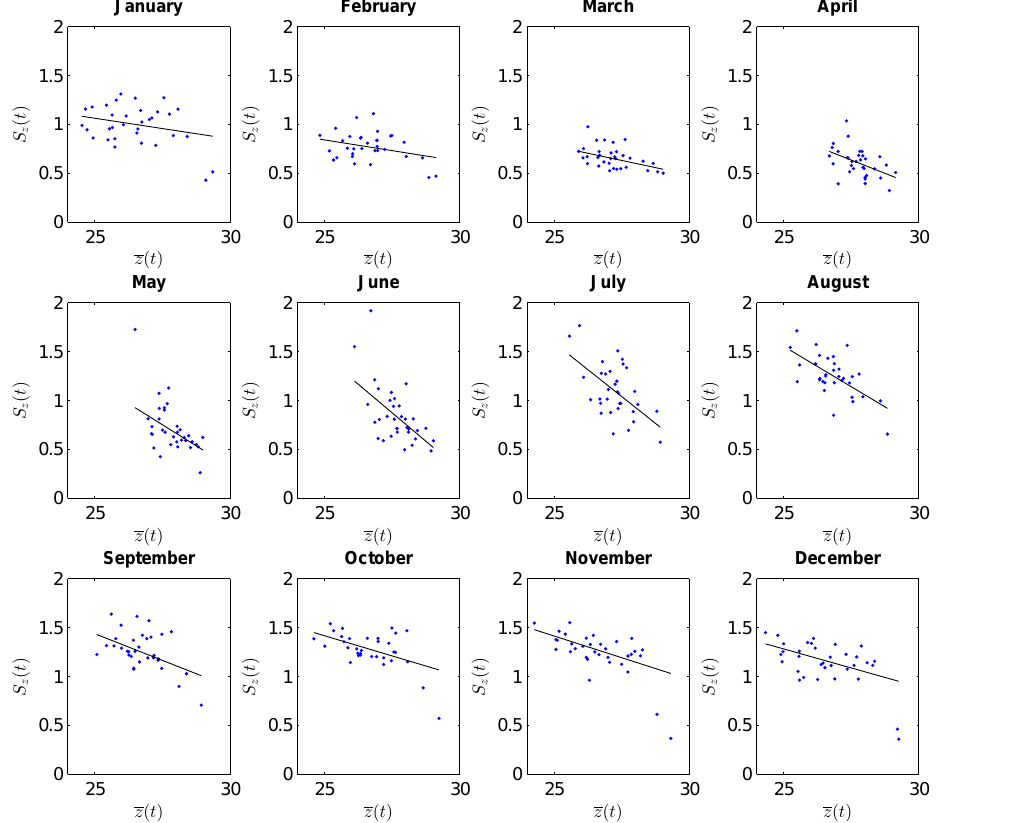
Figure 4. Spatial standard deviation, S z ( t ), vs. spatial mean, z ( t ), in the Niño 3.4 region, for all t ∈ D Jan t ,t ∈ D Feb t ,...,t ∈ D Dec t , with the WTS-estimated lines superimposed. Units on both axes are ◦